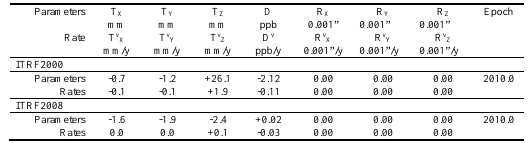
Table 3. Transformation parameters and their rates from ITRF2000 and ITRF2008 to ITRF2014 at epoch 2010.0 (Source: